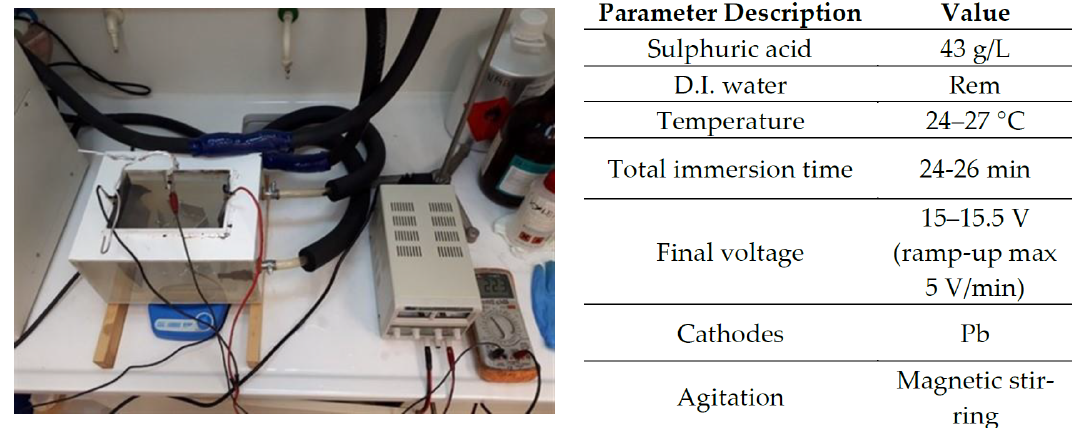
Figure 1. Experimental setup for the thin film sulphuric acid anodising (TFSAA) alongside TFSAA process